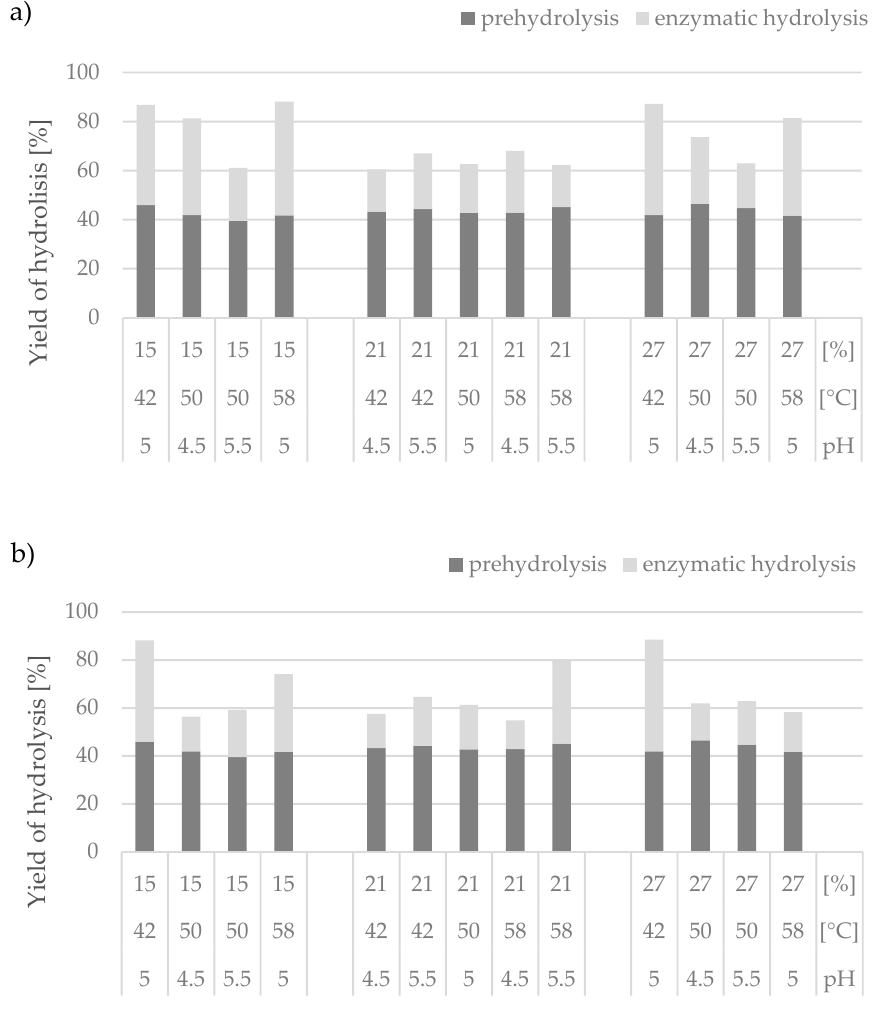
Figure 2. E ffi ciency of the prehydrolysis and enzymatic hydrolysis process with ( a ) C1 and ( b ) CTec2 enzymes.